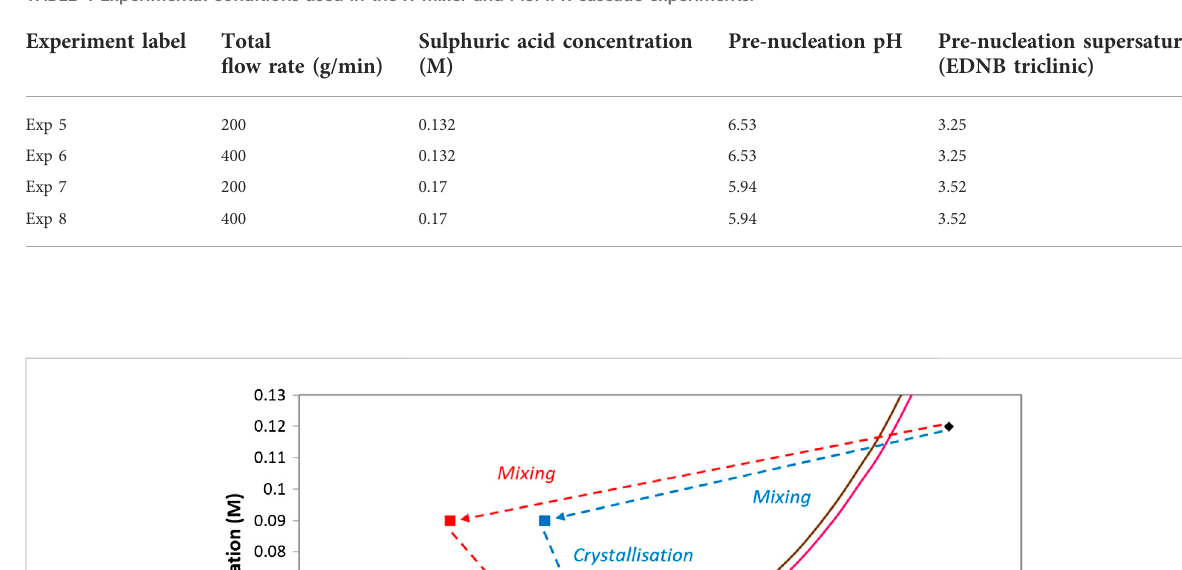
TABLE 4 Experimental conditions used in the X-mixer and MSMPR cascade experiments.